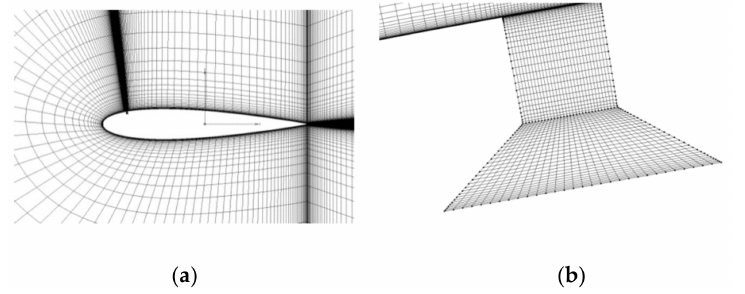
Figure 3. The mesh around NACA 0015 airfoil. ( a ) C-grid detail and ( b ) zoomed-in view near the